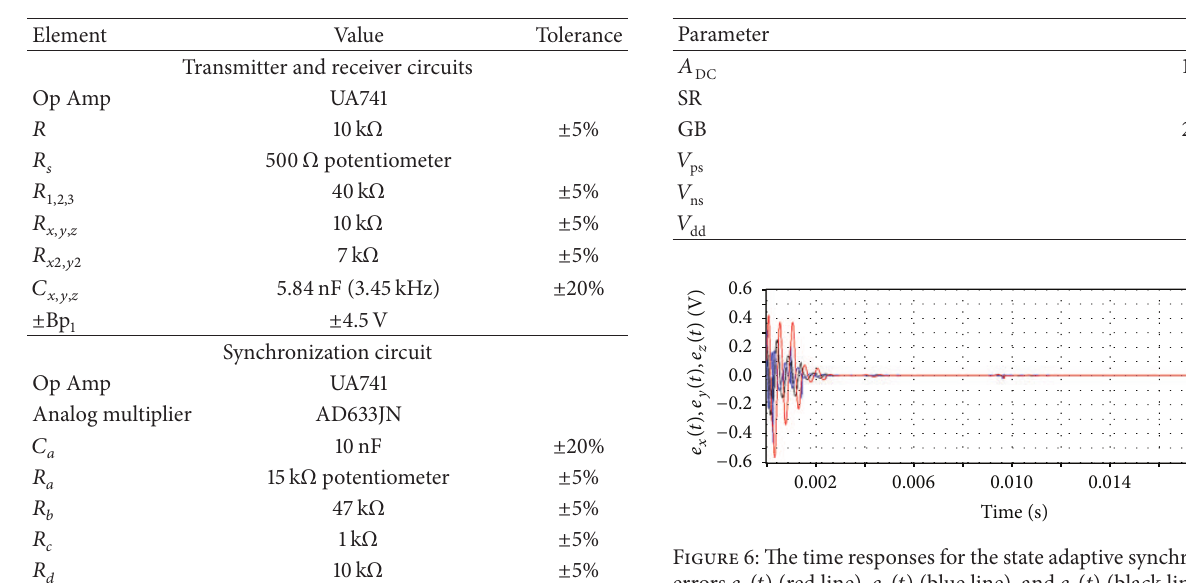
Table 1: Component list from Figure 3. Table 2: Performance parameters of the UA741 Op Amp.